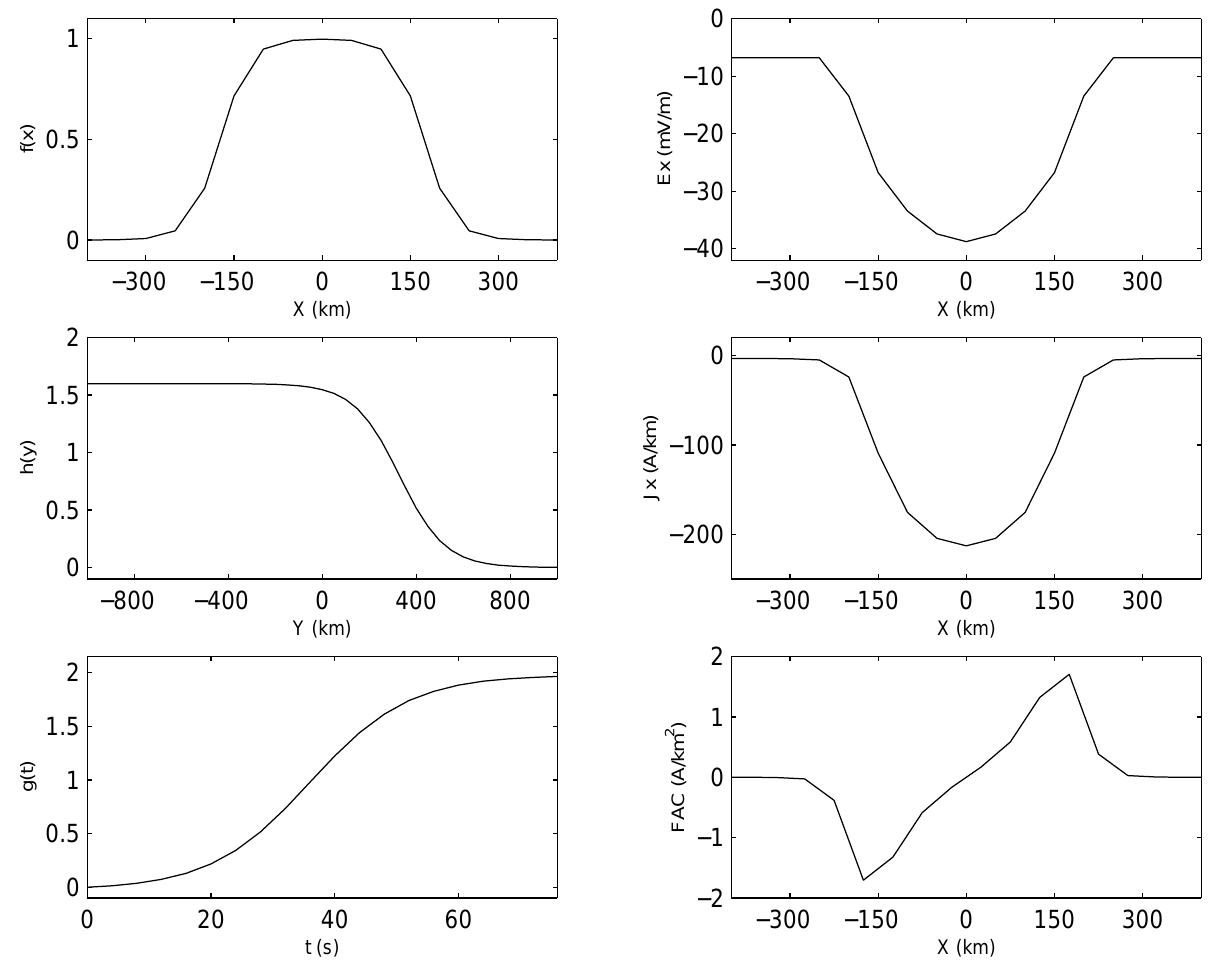
Fig. 4. On the left side the functions f (x) , h(y) and g(t) giving the spatial and temporal dependences of the electrojet model (Eq. 4). On the right side the cross sectional shape of the North-South directed electric field and current together with